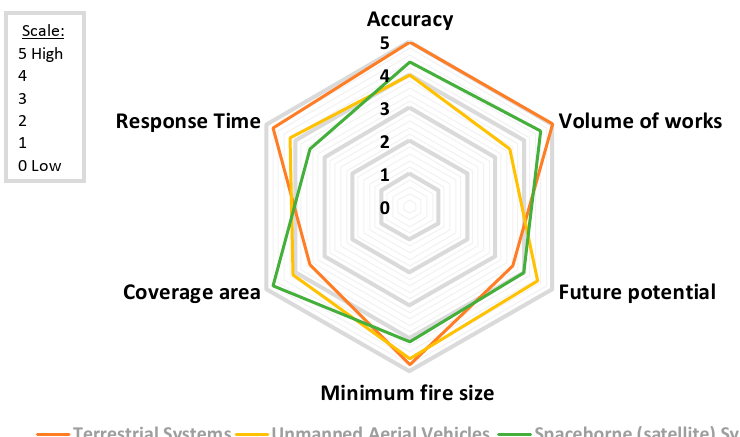
Figure 3. Radar chart showcasing the findings of this review for different early forest fire detection systems with regards to accuracy, response time, coverage area, future potential, and volume of works in the scale 0 (low) to 5 (high).